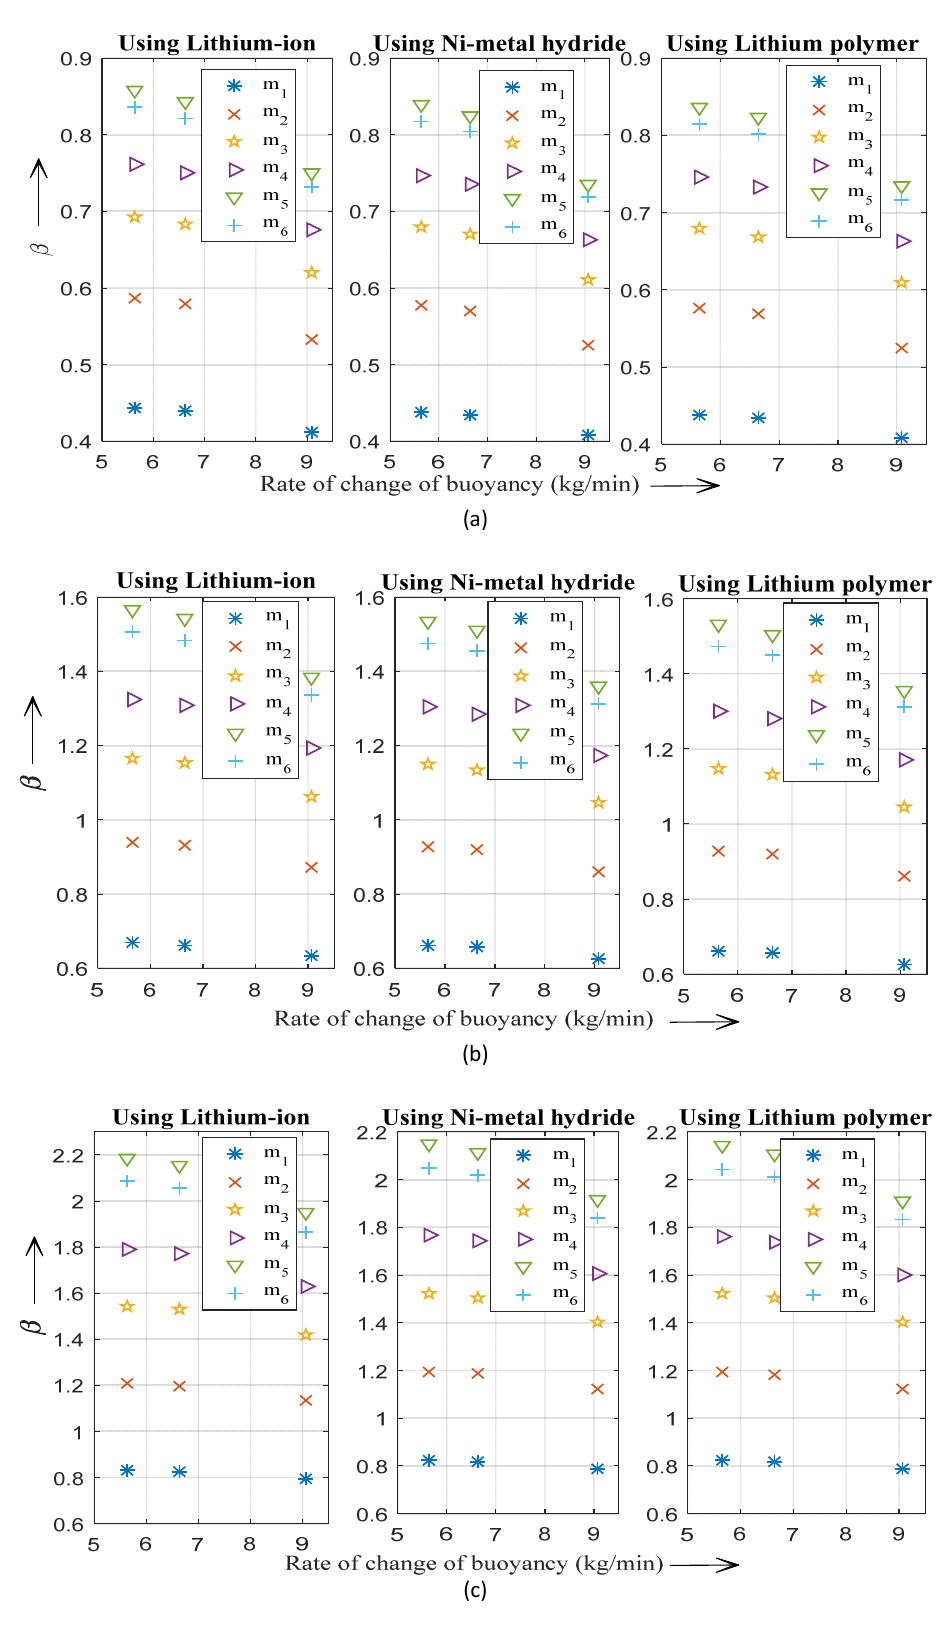
Figure 8. ( a ) Rate of change of buoyancy vs. weight of VBS for B = 5 kg, ( b ) Rate of change of buoyancy vs. weight of VBS for B = 10 kg and ( c ) Rate of change of buoyancy vs. weight of VBS for B = 15